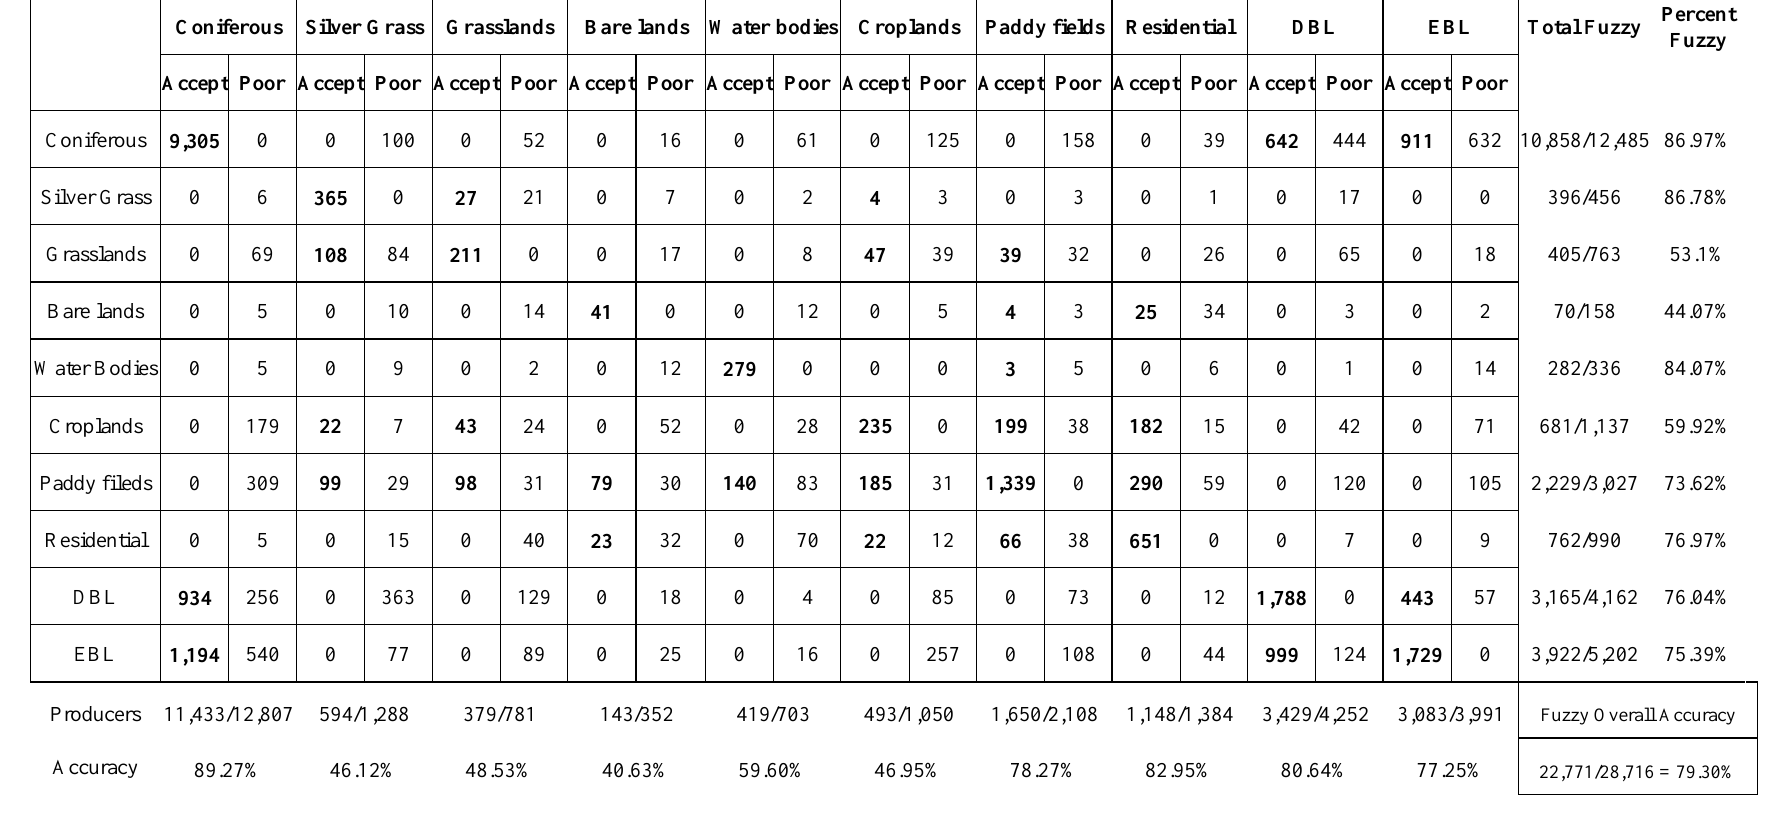
Table 4. Fuzzy Error Matrix [43,44] following the same methodology as the traditional error matrix with the following additions: Non-diagonal cells in the matrix contains accepted and poor columns. The numbers in the accepted columns are considered a “match” for estimating fuzzy accuracy, the numbers in the poor columns are considered as an error. The fuzzy overall accuracy is estimated as the percentage of sites where the acceptable reference labels matched the classified